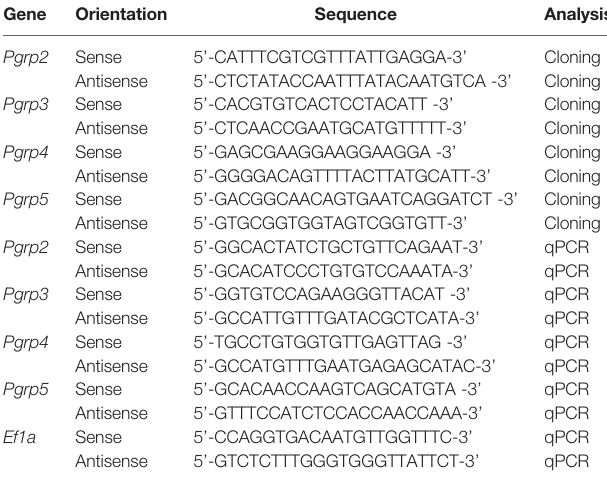
TABLE 1 | Oligonucleotides for speci fi c